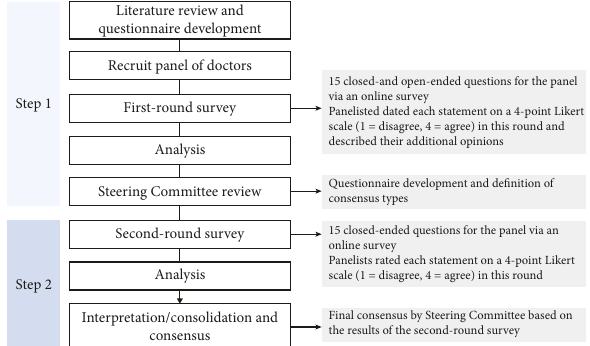
Figure 1: Delphi review process. Expert opinions and consensus recommendation process. The development process was based on the Delphi method for conceptualizing, designing, and carrying out the appropriate procedures for the diagnosis and treatment of Parkinson’s disease. The method consists of a Delphi approach, in which a panel of Japanese Parkinson’s disease experts assessed the appropriateness of clinical decisions in an iterative